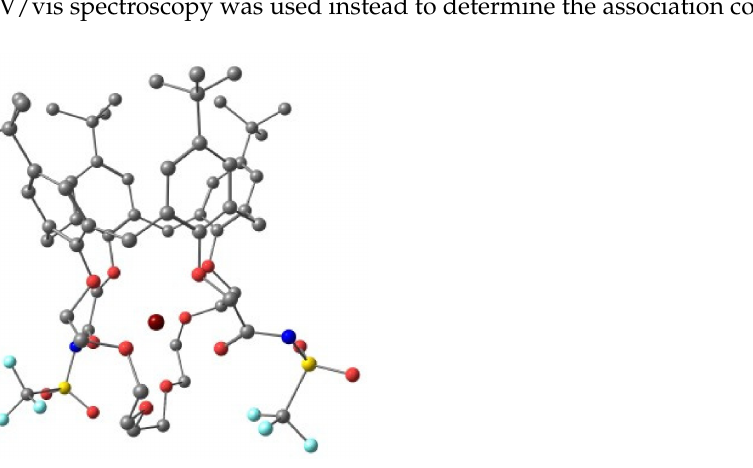
Figure 2. The optimized geometrical structure of the Ba-complex Ba-20 (hydrogen atoms are hidden for clarity; the colors of the atoms are: carbon; grey, fluorine; green, sulfur; yellow, nitrogen; blue, oxygen; red, barium; brown).